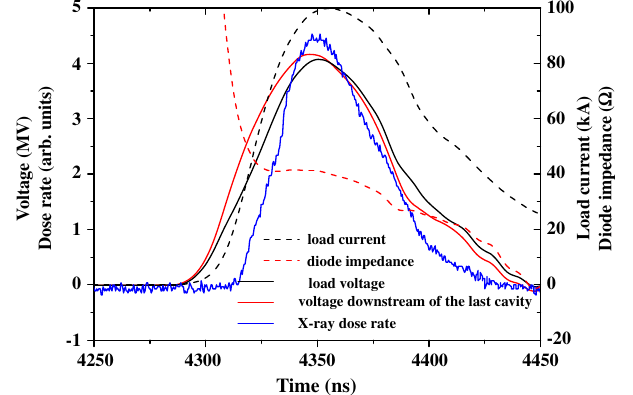
FIG. 13. The load current (black dashed line), RPD impedance (red dashed line), load voltage (black solid line), voltage down- stream of the last cavity (red solid line), and X-ray dose rate (blue solid line). The load voltage is determined by induction correc- tion from the voltage pulse obtained downstream of the last cavity. Since the RPD is close to the position of the B-dot sensor depicted in Fig. 8, the current waveform given by this monitor is regarded as the load current. Its amplitude was 100 kA.